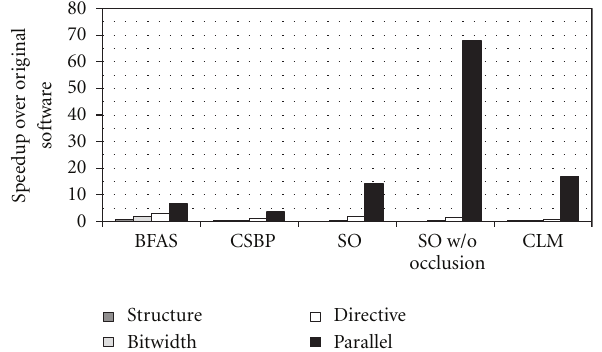
Figure 9: Speedup over original software for each algorithm for each ISE synthesizable optimization